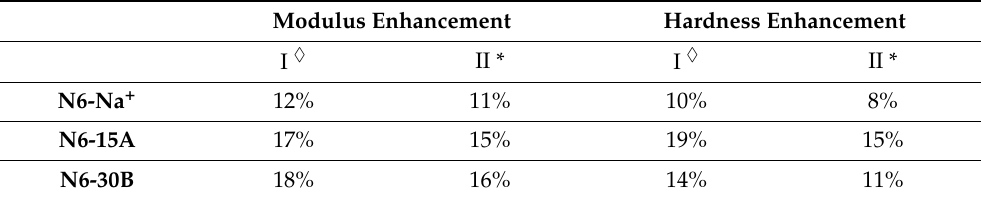
Table 3. Nanoindentation modulus and hardness enhancements for the different composite samples.